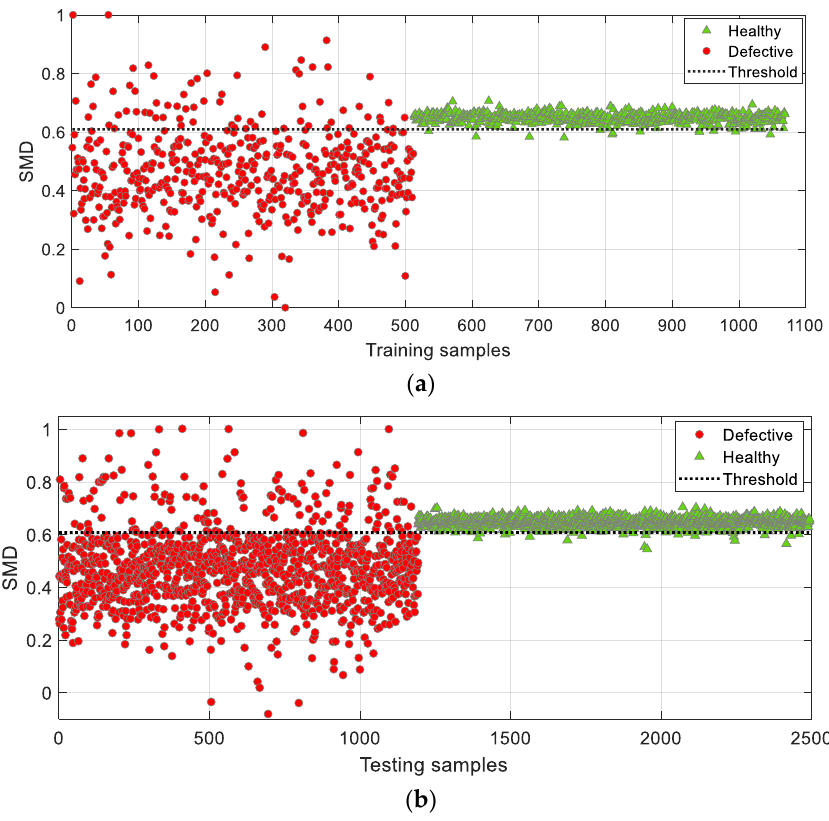
Figure 12 . ( a ) Classification on the training dataset; ( b ) classification on the testing dataset.